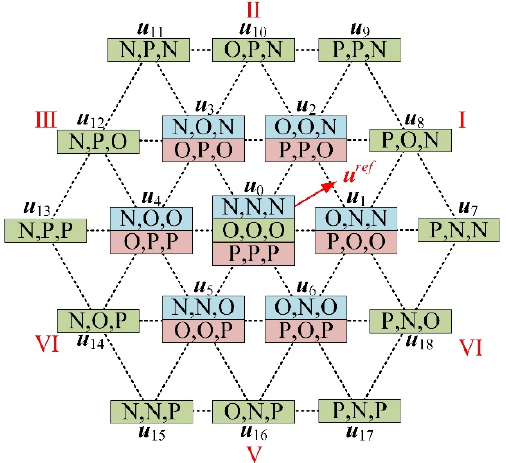
Figure 2. Basic voltage vectors of the three-level three-phase inverter.